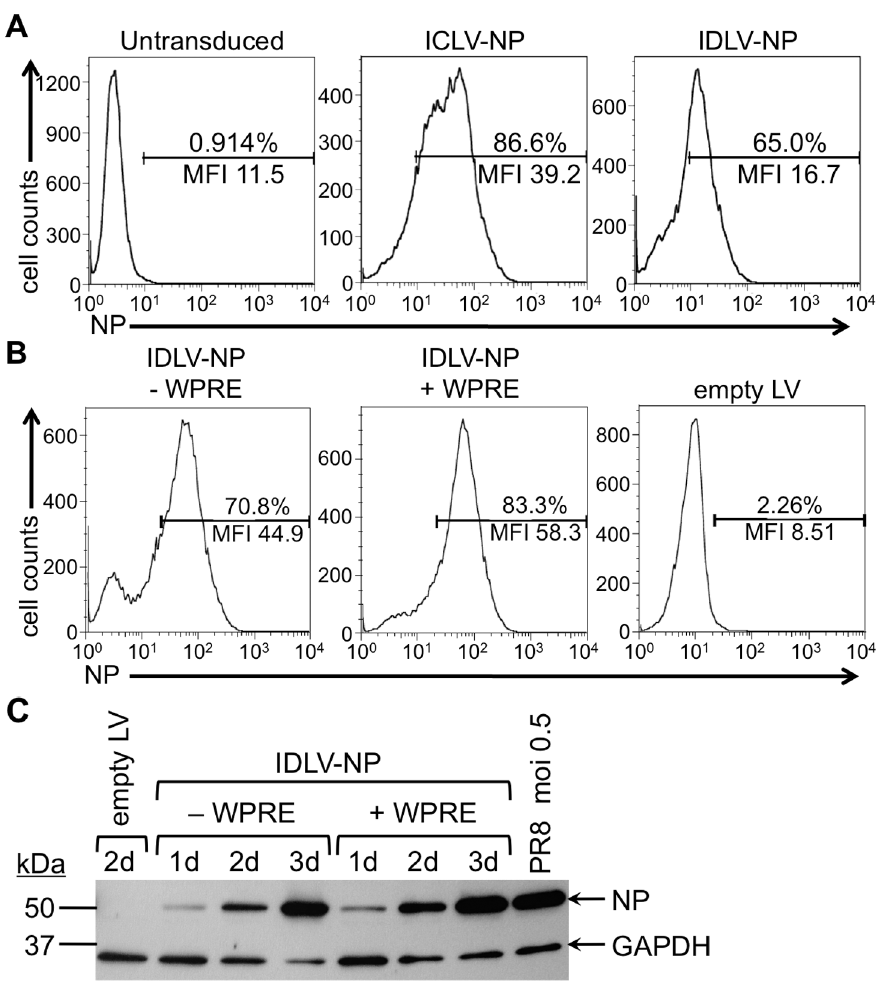
Figure 2. IDLV express NP protein invitro . ( A ) 293T cells transduced with IDLV-NP or ICLV-NP with a multiplicity of infection (MOI) of 3 were fixed and stained at day 2 post-transduction with a FITC-conjugated antibody against influenza A virus NP, then measured by flow cytometry. Untransduced cells were used as a negative control. The percentage of FITC-positive cells and mean fluorescence intensity (MFI) in each sample is indicated. ( B ) 293T cells were transduced for 1 day with IDLV-NP ( + or 2 WPRE) (MOI=3), fixed and stained with a FITC-conjugated antibody against influenza A virus NP, and then measured by flow cytometry. The percentage of FITC-positive cells and MFI in each sample is indicated. ICLV-empty was used as a negative control (empty LV). ( C ) Lysates from cells transduced as described in panel B were collected on day 1, 2 or 3, and probed for influenza virus NP ( , 56 kDa) by western blot. Equivalent amounts of protein (9 m g) from each sample were loaded. Lysate from cells infected with PR8 influenza virus (MOI=0.5) was used as a positive control for protein